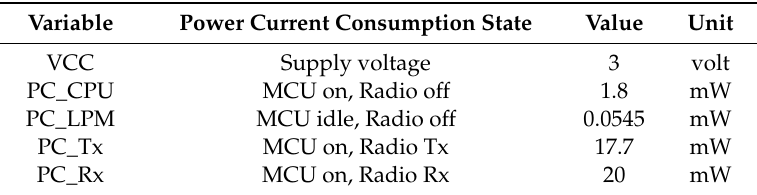
Table 2. Power parameters in Tmote-Sky based on